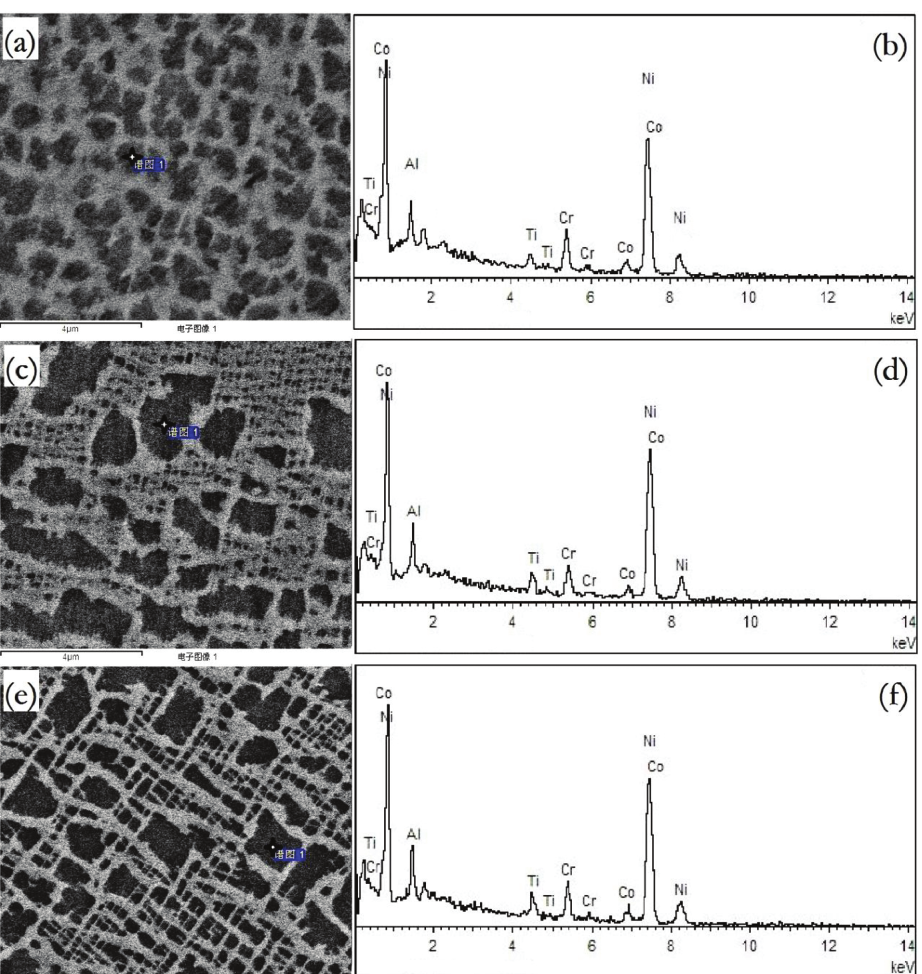
Figure 6: EDS spectrum of γ ′ phase in non-HIPed and HIPed specimens (a), (b) Cas; (c), (d) H35; (e), (f) H45.